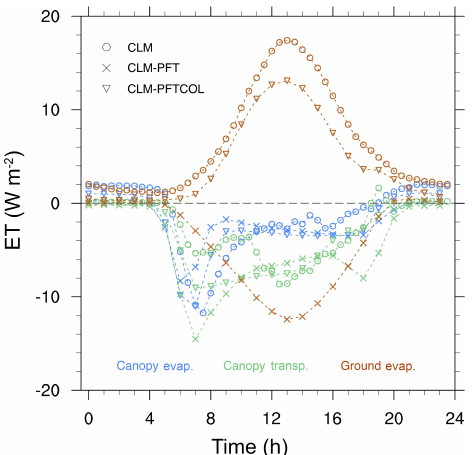
Figure 3. Change in the diurnal cycle of components (colors) of evapotranspiration (canopy evaporation, canopy transpiration, and ground evaporation) due to LULCC from forest to open land (open − forest).